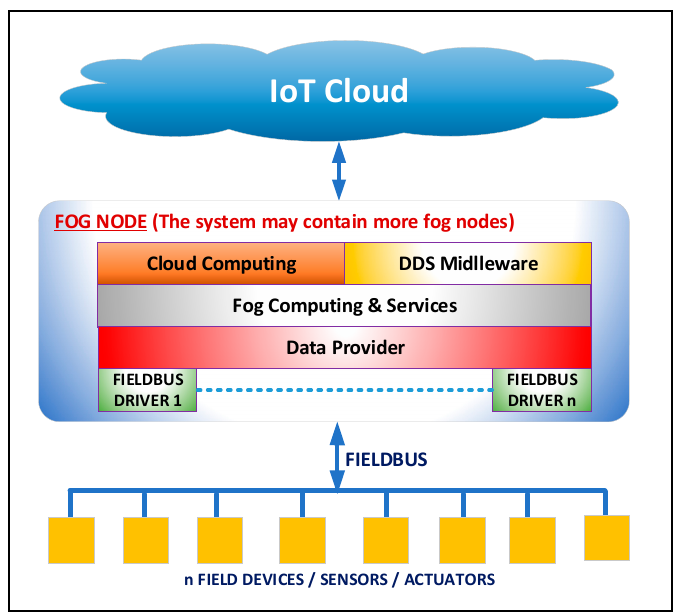
Figure 1. The general architecture of the proposed fog